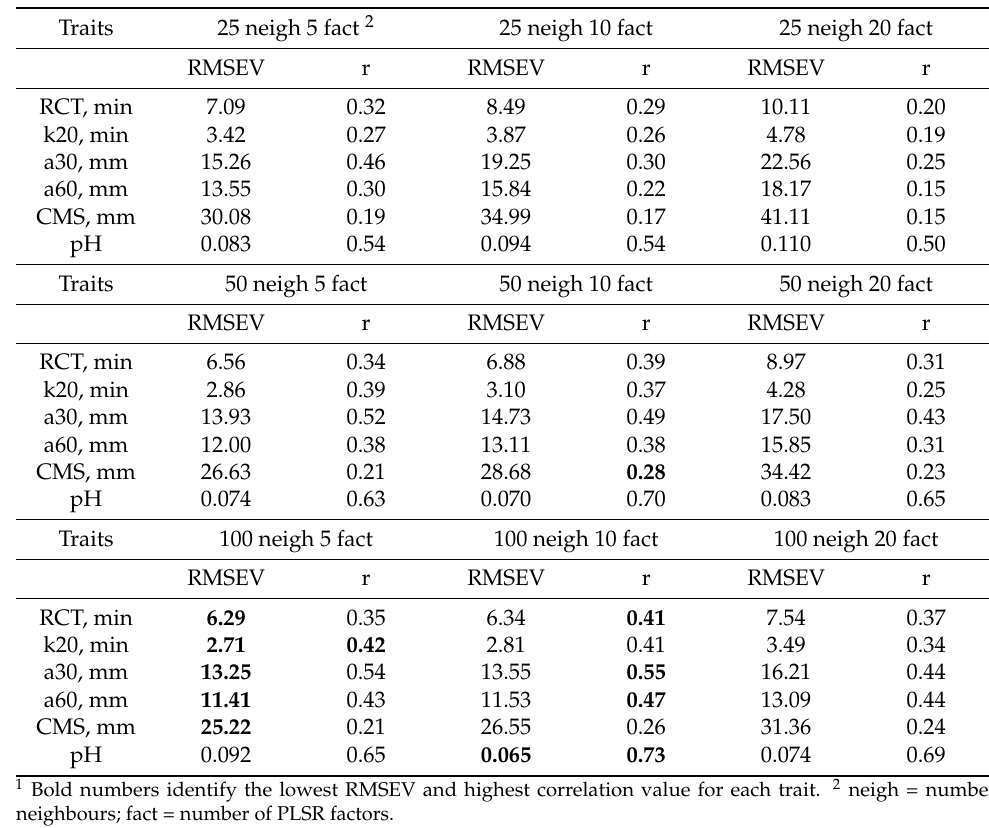
Table 3. Root mean square error of validation sample (RMSEV) and correlation (r) between the true and predicted trait values across different LOCAL settings 1 .